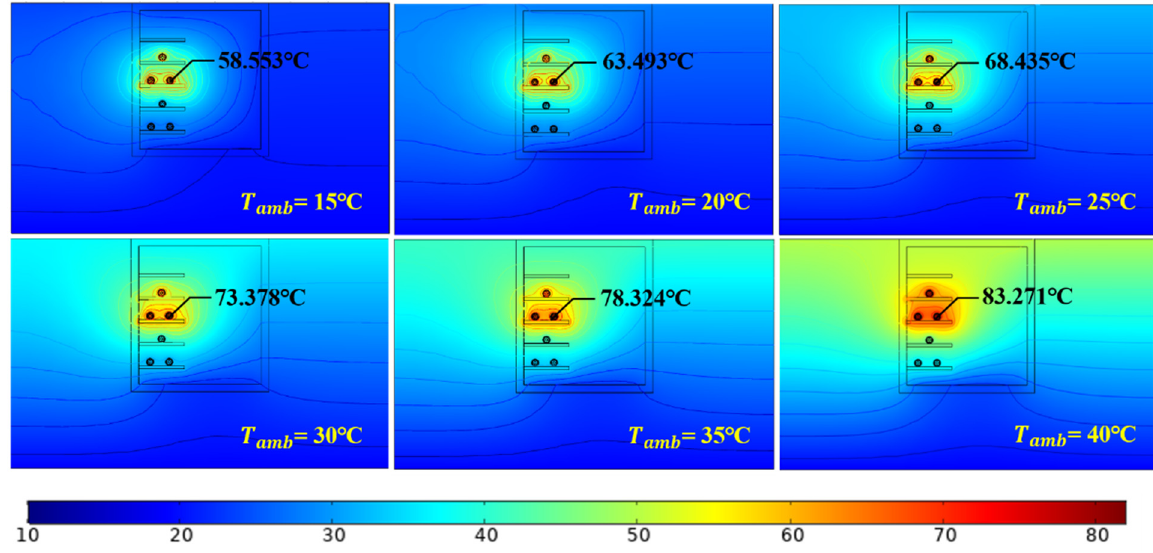
Figure 3. The cable trench temperature distribution at different temperatures T amb.